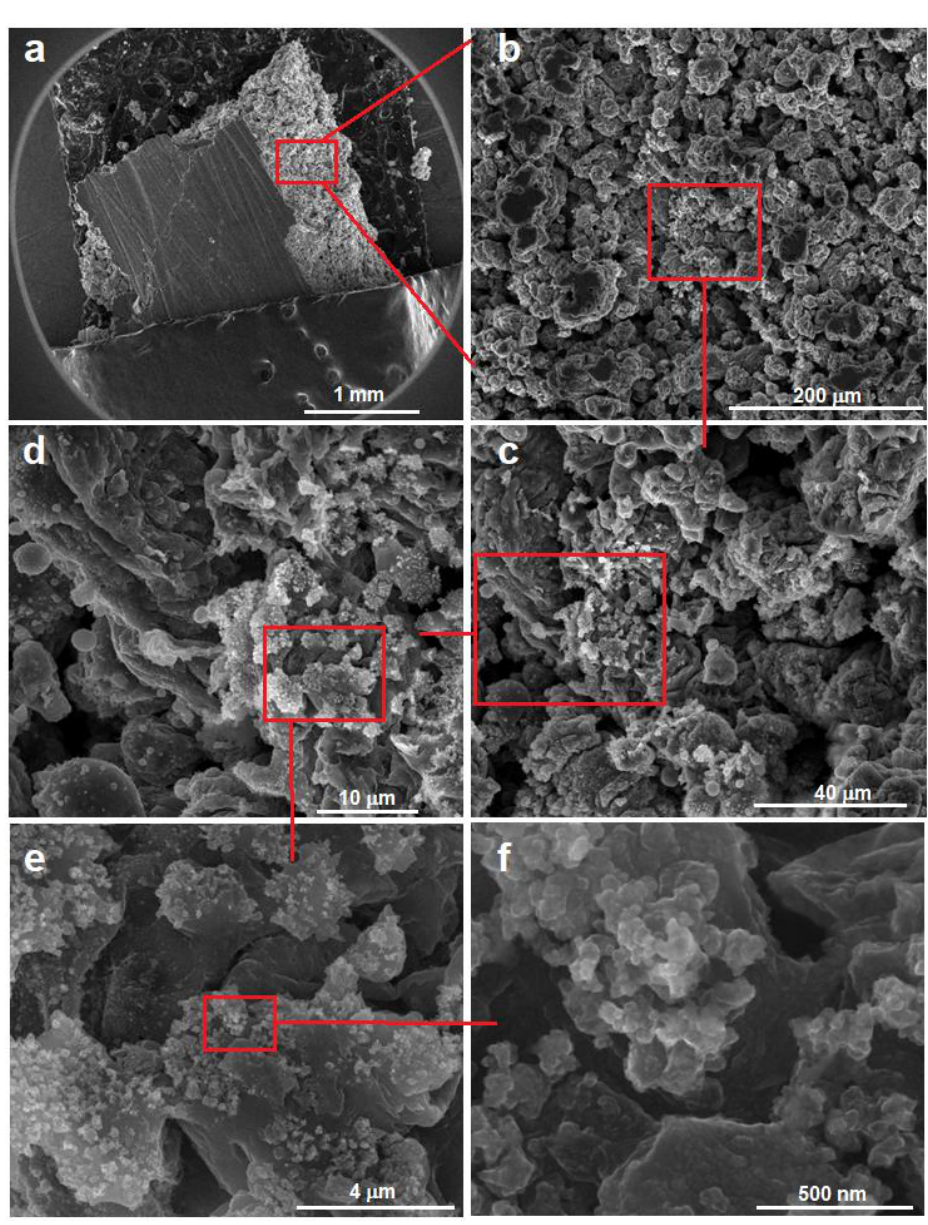
Figure 11. The SEM-SE images for the studied Mg-based powder-alloy after processing by selective laser melting — SLM. (from a – f ) the same sample, with gradual increase in magnification.